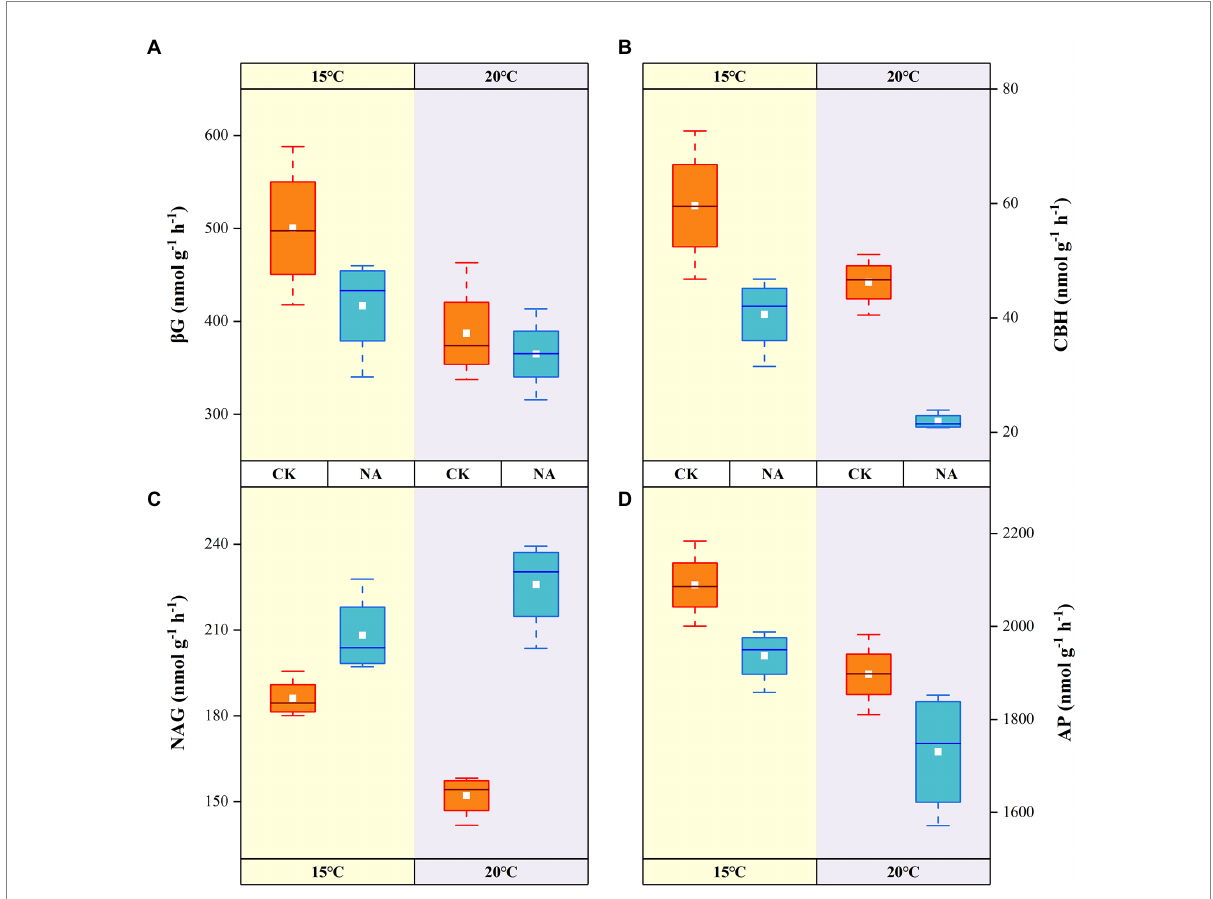
FIGURE 5 Effects of temperature rising and nitrogen addition on soil enzyme activities in permafrost peatland. CK, control; NA, add 50 mg N kg − 1 soil. β G, β -1,4-glucosidase (A) ; CBH, cellobiohydrolase (B) ; NAG, β -1,4-N-acetylglucosaminidase (C) ; AP, acid phosphatase (D)